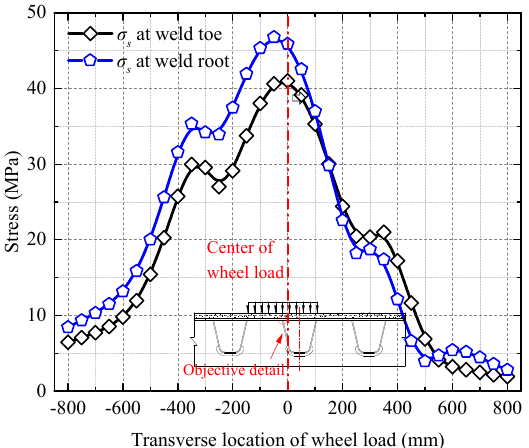
Figure 18. Stress influence lines of rib-deck weld.